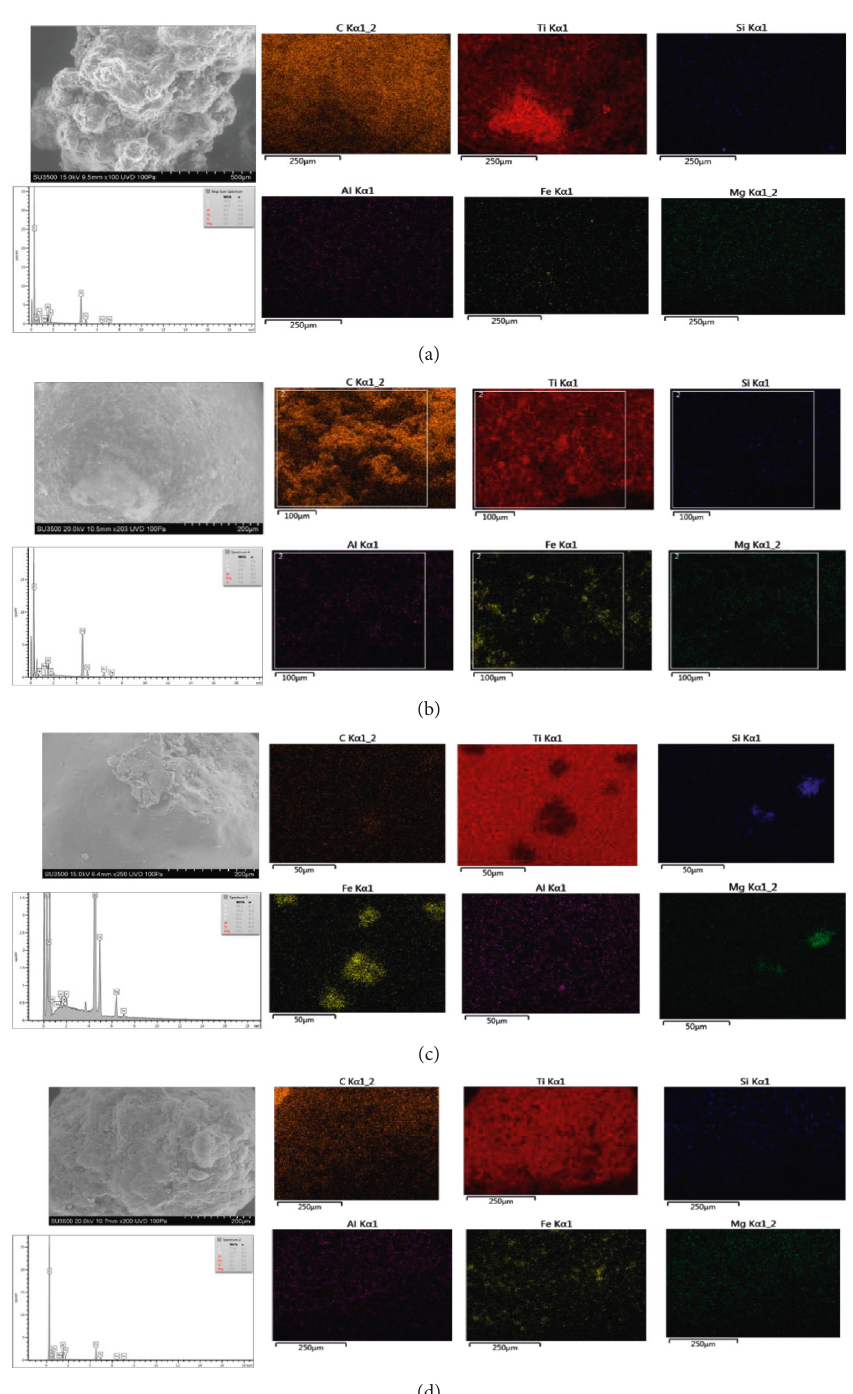
Figure 5: (a) Elemental composition of Premix-1. (b) Elemental composition of Premix-2. (c) Elemental composition of Premix-3. (d) Elemental composition of positive control